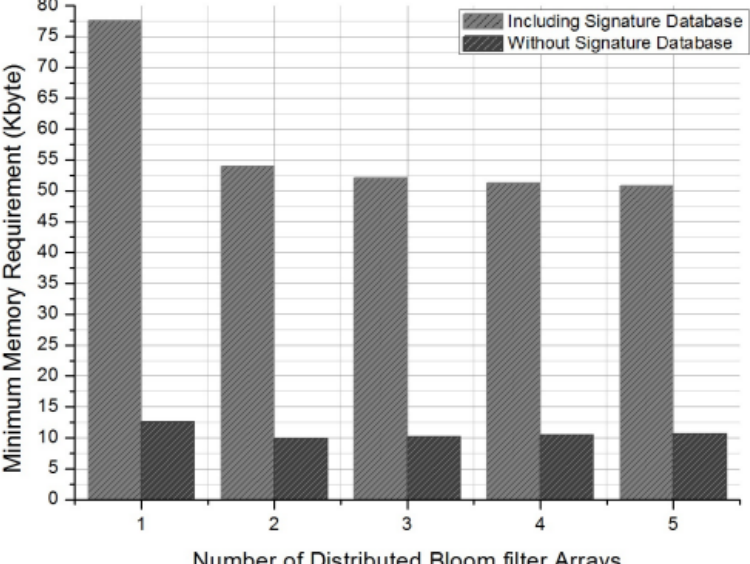
Figure 6. Minimum memory requirements according to the number of distributed Bloom filter arrays j